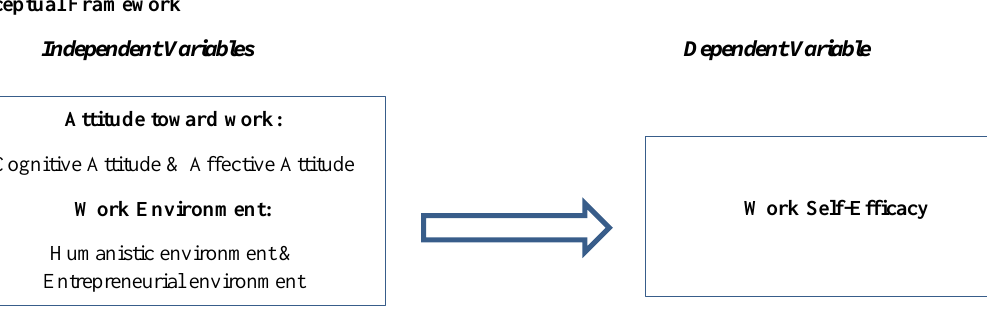
Figure 1: The conceptual framework indicates the correlation between the independent variables and dependent variables. Attitude toward work and work environment are predictors of self-efficacy; Source: Abun, et.al (2021), Pepe, et.al (2010). Statement of the